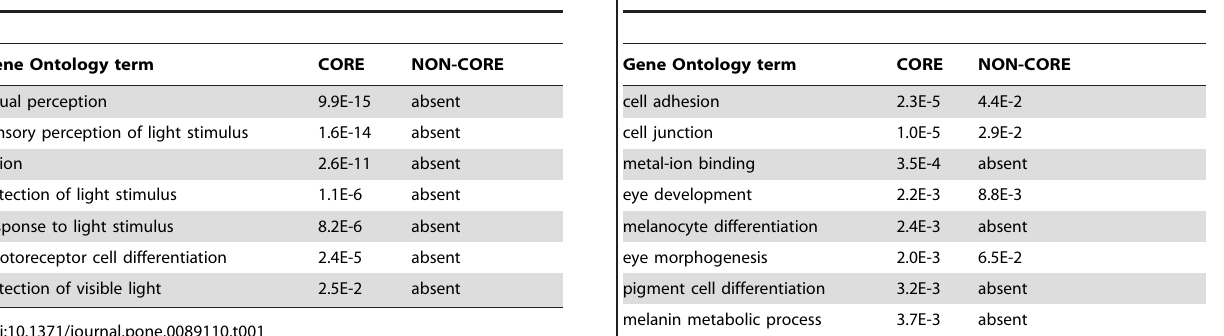
Table 1. Ontology term enrichment in core and non-core set of the neuroretina.